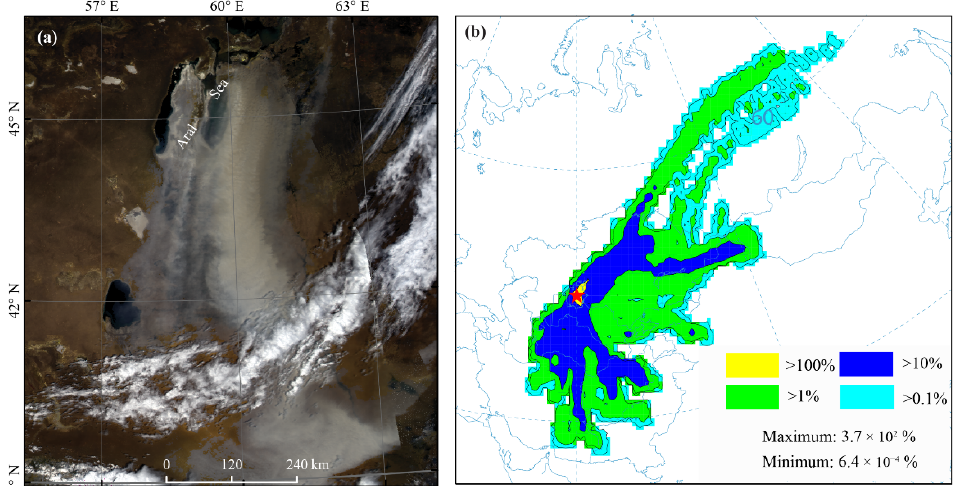
Figure 10. Sand and dust storm that occurred on 27 May 2018, captured by MODIS ( a ) and potential long-range transport of the atmospheric aerosols from the Aral Sea Basin, derived from HYSPLIT model ( b ).